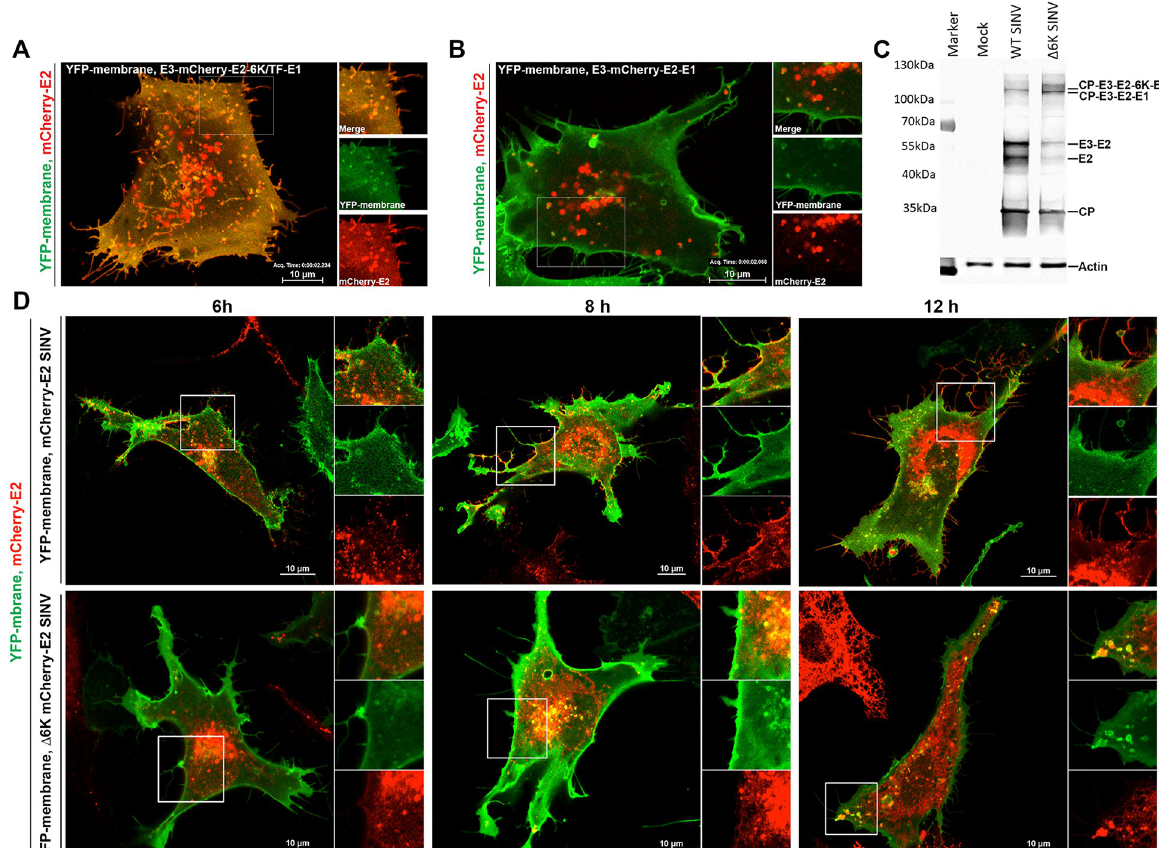
Fig 3. 6K is required for glycoprotein trafficking to the plasma membrane. (A-B). Representative images of BHK-15 cells co-transfected with YFP-membrane (green) and E3-mCherry-E2-6K/TF-E1 (red) (A) or E3-mCherry-E2-E1 (red) (B). Images were collected at 12 h post- transfection. Images correspond to videos (S1 and S2 Videos). (C) Western blot analysis of cell lysates from BHK-15 cells infected with WT SINV or Δ 6K SINV. The blot was probed with an anti-E2 primary antibody to detect the structural polyprotein-processing intermediates. (D) Images of BHK-15 cells transfected with YFP-membrane (green) and RNA corresponding to mCherry-E2 SINV (red) or Δ 6K mCherry-E2 SINV (red). Images were collected at the indicated time points post-electroporation. Regions of interest are marked and represented as zoomed to the right in separate